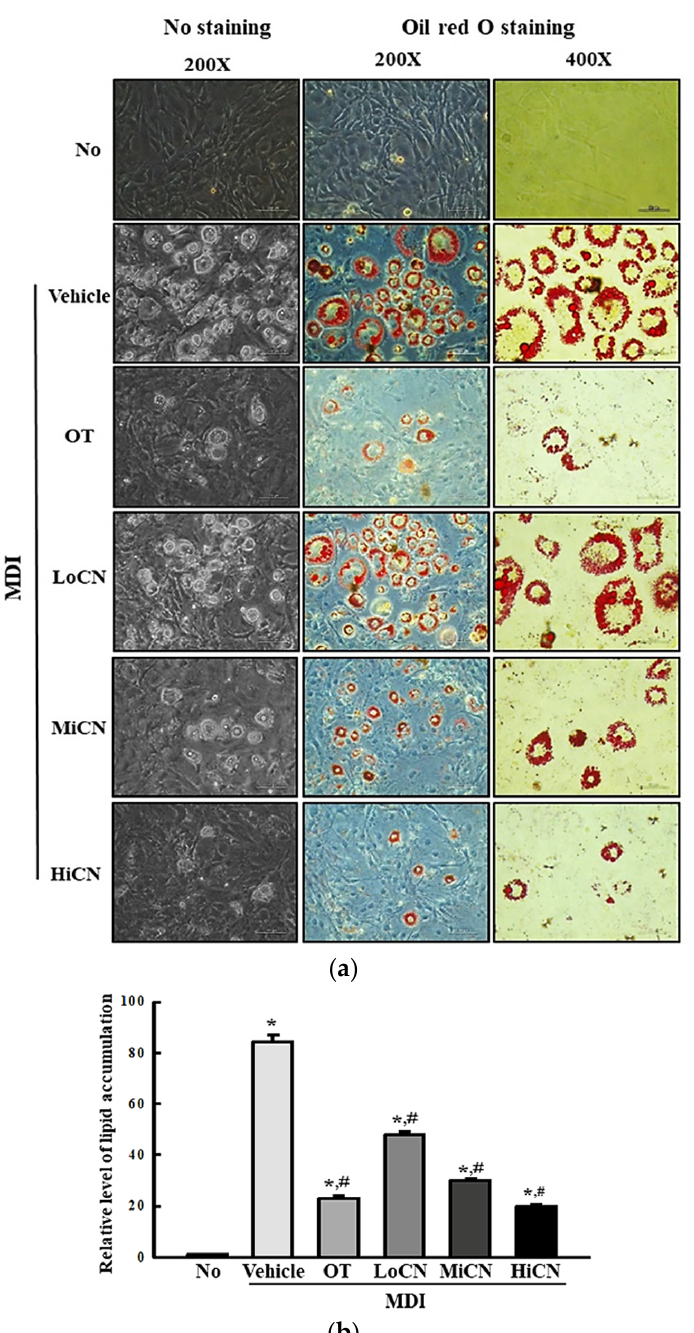
Figure 2. ORO staining analysis. ( a ) After inducing the differentiation with MDI media and treatment of α -cubebenol for eight days, 3T3-L1 adipocytes were stained with ORO dye solution. The images of the ORO-stained cells were observed under a microscope 200 × and 400 × magnification. ( b ) The optical density of red color was measured in the ORO-stained cells. Two to three wells per group were used for staining, and optical density was measured in duplicates. The data represent the means ± SD of duplicates. * indicates p < 0.05 compared to the No treated group. # indicates p < 0.05 compared to the MDI + Vehicle treated group. ORO, Oil Red O; OT, orlistat; MDI, adipogenic cocktail consisting of 3-isobutyl-1-methylxanthine, dexamethasone, and insulin; LoCN, low concentration (7.5 µ g/mL) of α -cubebenol; MiCN, middle concentration (15 µ g/mL) of α -cubebenol; HiCN, high concentration (30 µ g/mL) of α -cubebenol.